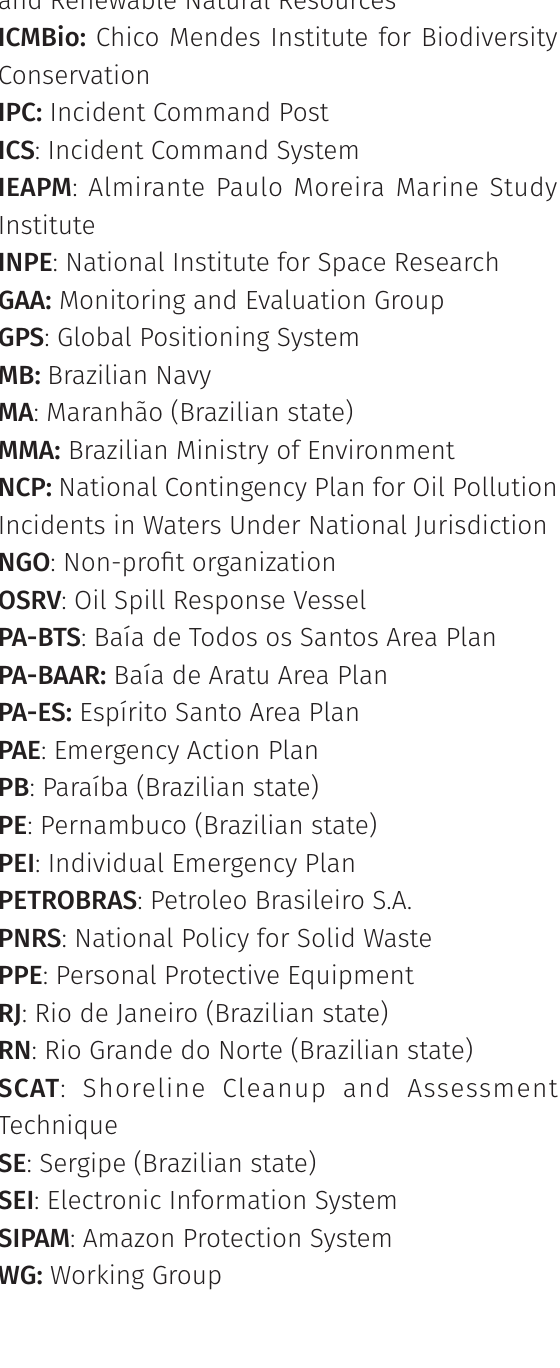
Aquasis: Association for Research and